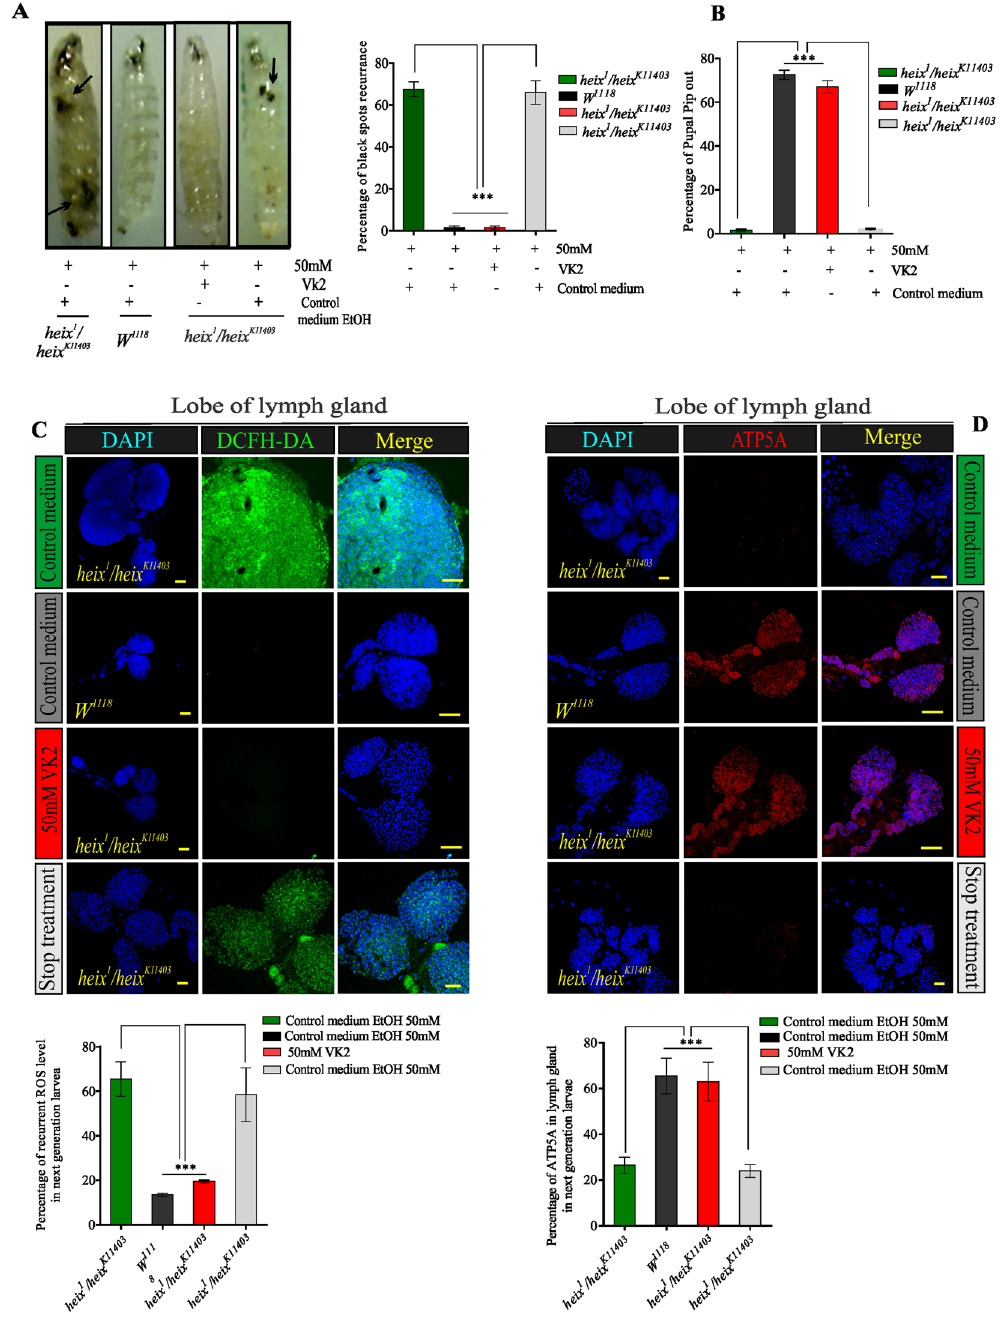
Figure 7. Prevention of lymphoma was vitamin K2 dependent. Testing the ability of VK2 to reduce recurrence of lymphoma. Follow-up of second-generation flies fed on VK2, divided into two groups: one group continuously reared on VK2 medium and the other on ordinary control medium. ( A ) Reappearance of black spots after stopping VK2 treatment. The percentage of larvae with recurrent spots very high. ( B ) Pupal pip out rate of adult flies decreased after stopping VK2 treatment. ( C ) ROS expression clearly increased after stopping VK2 treatment, recurrence of ROS release was significant. DAPI stain (blue) and ROS staining (CM-H2DCFDA) (green). ( D ) Inhibition of ATP production after stopping VK2 treatment, decrease in ATP production was significant. DAPI stain (blue) and anti-ATP antibodies (ATP5A). Control media contain 50 mM Ethanol (EtOH) and treatment media contain 50 mM VK2. Means normalized to control ( Canton S ). Error bars indicate SEM. Analysis of variance (ANOVA/Dunnett: * P < 0.05, ** P < 0.01, *** P <